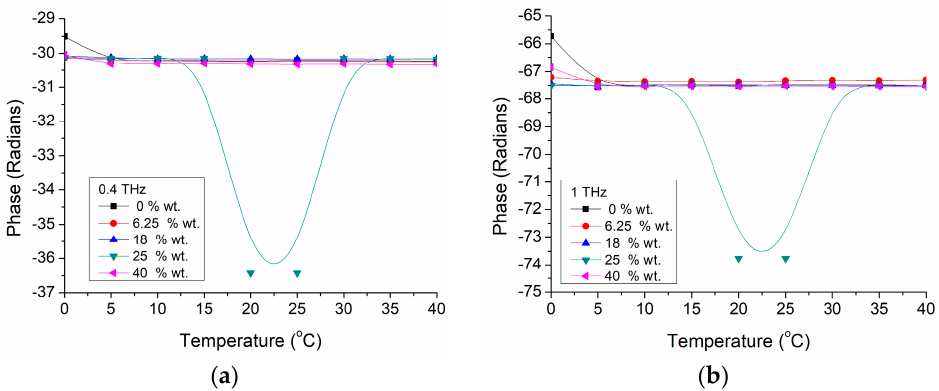
Figure 8. BTO-gelatin phase variation with temperature at two frequencies of ( a ) 400 GHz and ( b ) 1 THz.